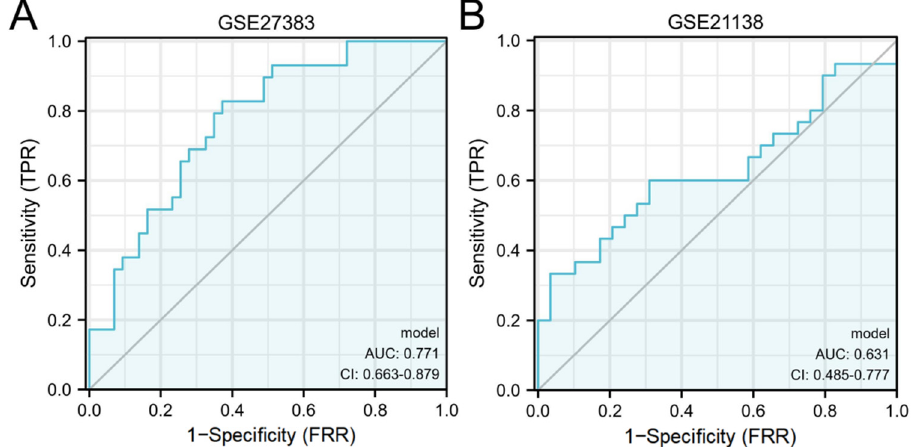
Figure 9. Examination of joint markers for diagnosis. A.GSE27383; B.GSE21138.